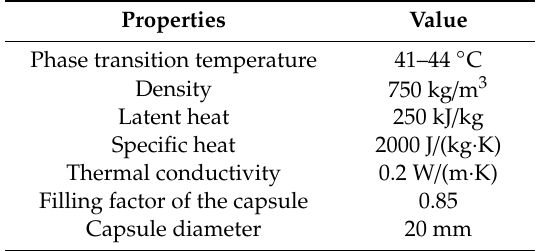
Table 2. Main thermophysical properties of Rubitherm’s RT44HC